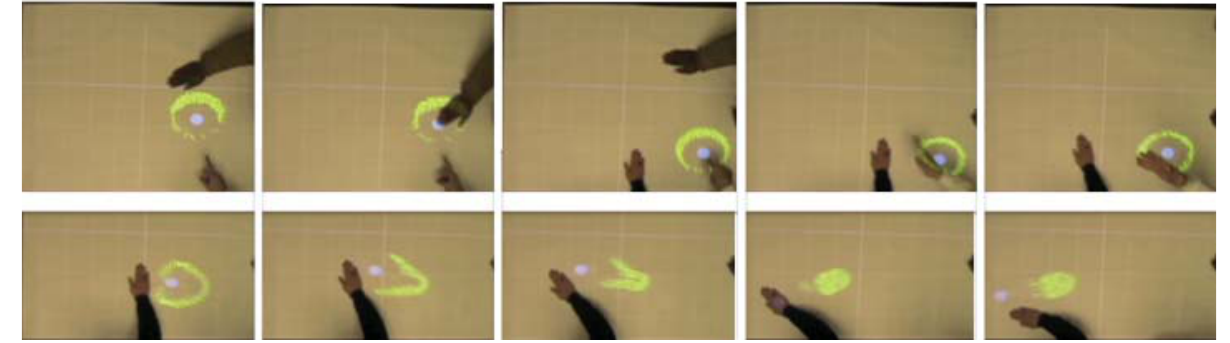
Figure 3a: Top row: Novice players attempt accelerated movements to separate one cluster into two. Figure 3b: Bottom row: Player learns to apply steady movement to separate one cluster into